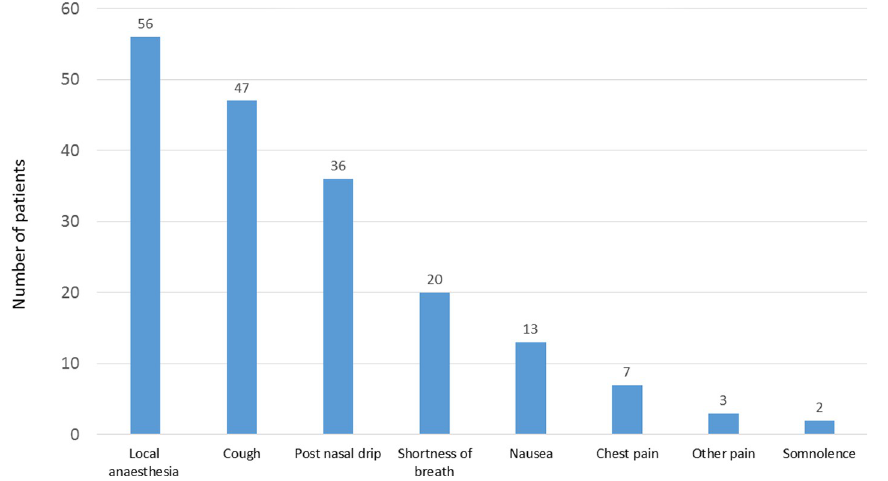
Fig 3. Factors associated with patients’ discomfort during bronchoscopy.